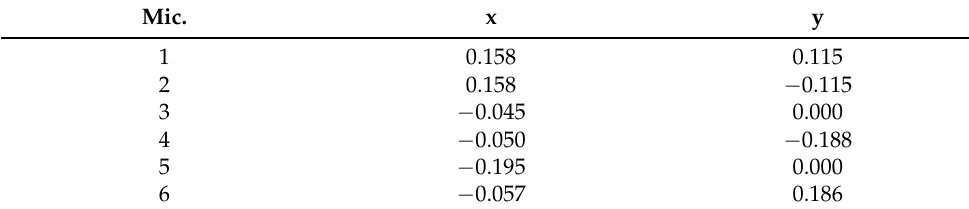
Figure 4. Three-dimensional microphone array of AIRA recordings [6]. The positions of the microphones used are presented in Table 1. Table 1. Microphone positions in the 3D array